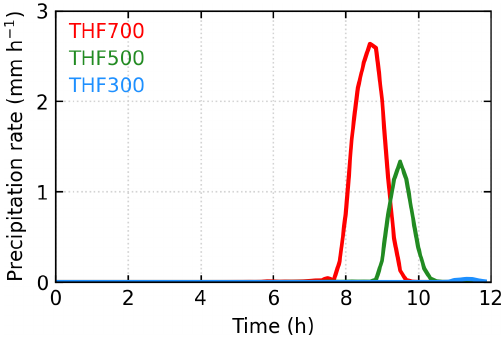
Figure 18. Mean surface precipitation rate over the land